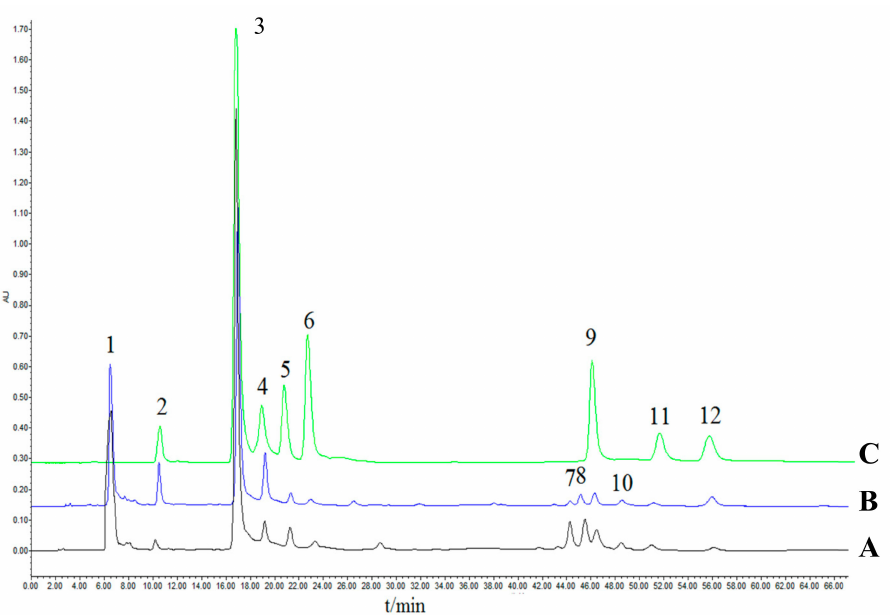
Figure 2. HPLC-PDA chromatograms of R9 samples: ( A ) P9 sample; ( B ) mixed standards; ( C )